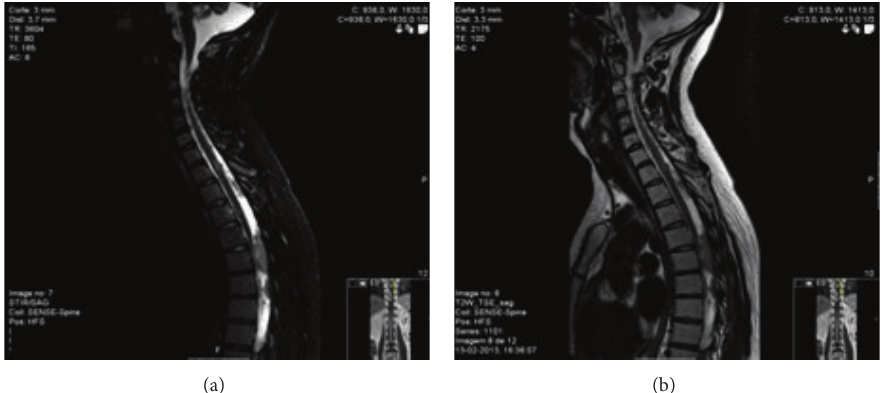
Figure 4: Reflecting widespread leptomeningeal infiltration, contrast capture was documented in the subarachnoid space from the level of